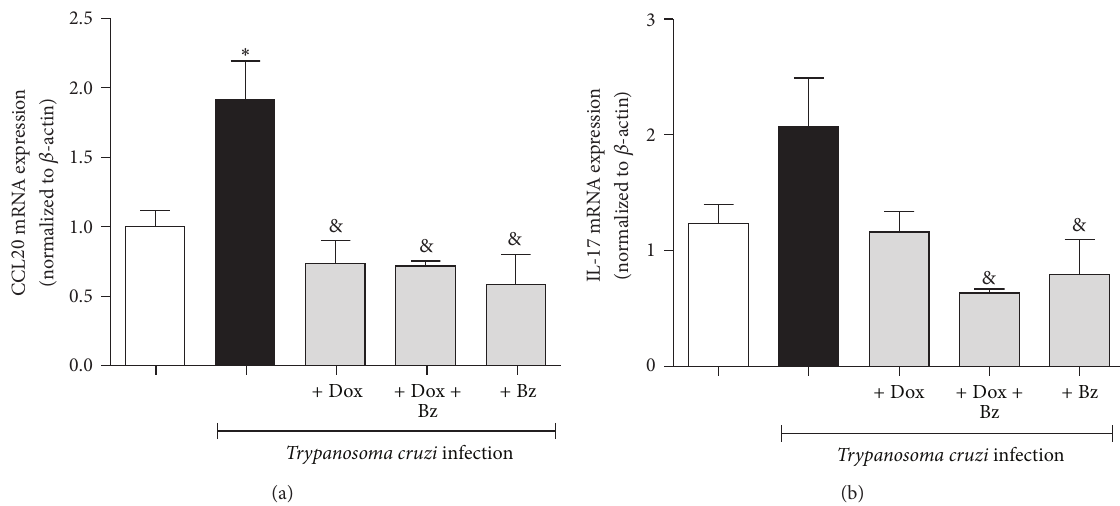
Figure 3: Expression of Th17-like chemokine CCL20 and IL-17 in the cardiac tissue from dogs infected with Trypanosoma cruzi . CCL20 and IL-17 mRNA expression evaluated in left ventricle tissues. Data are representative of groups ( 𝑛 = 5 animals) in which expression of chemokines was normalized to the constitutive beta-actin. & means difference ( 𝑝 < 0.05 ) in relation to the infected group without treatment; ∗ means difference ( 𝑝 < 0.05 ) in relation to the noninfected